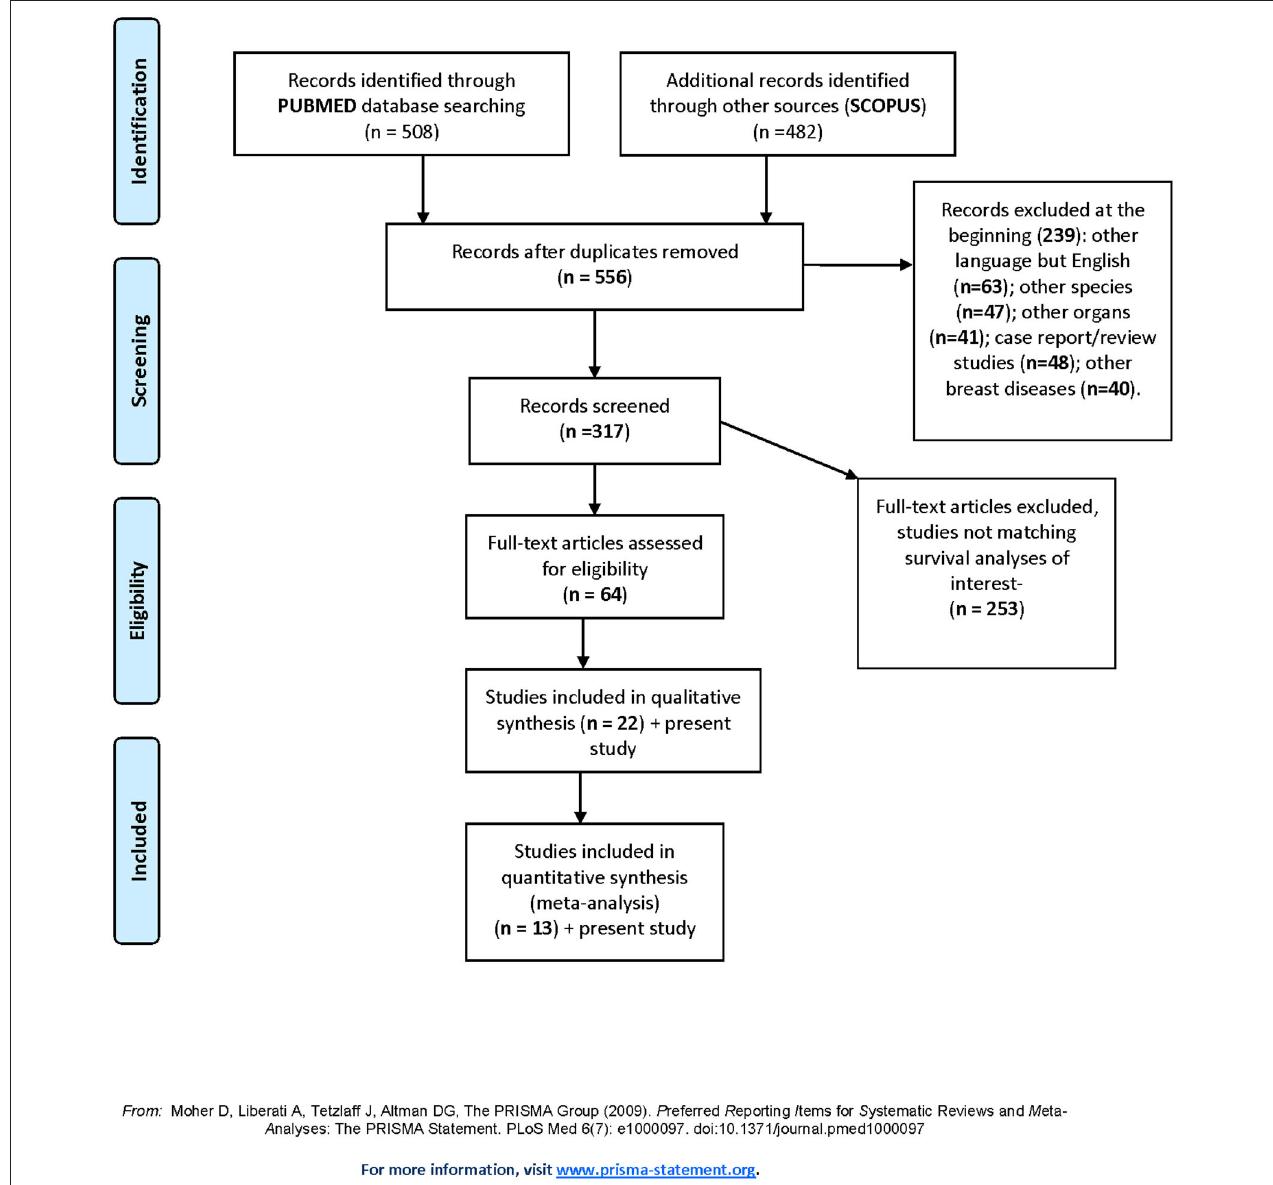
FIGURE 4 | Prisma flowchart.